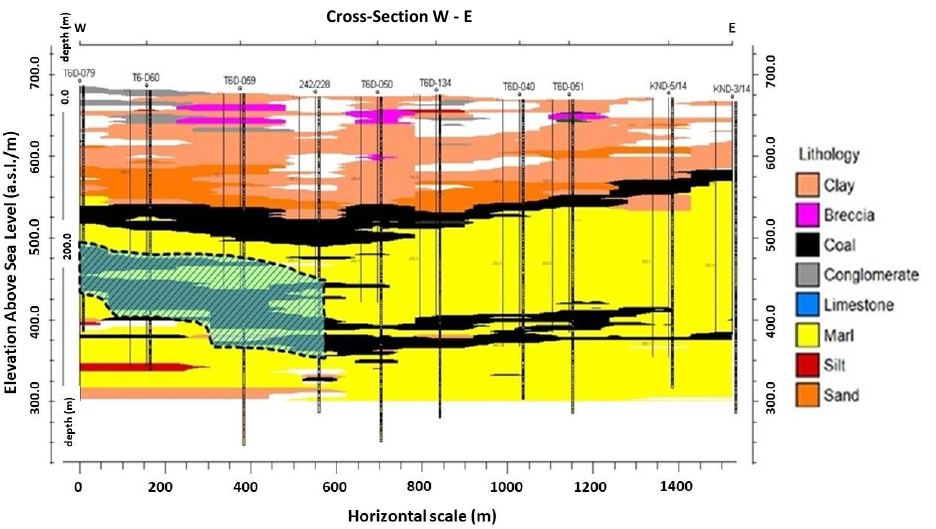
Cross-Section W - E